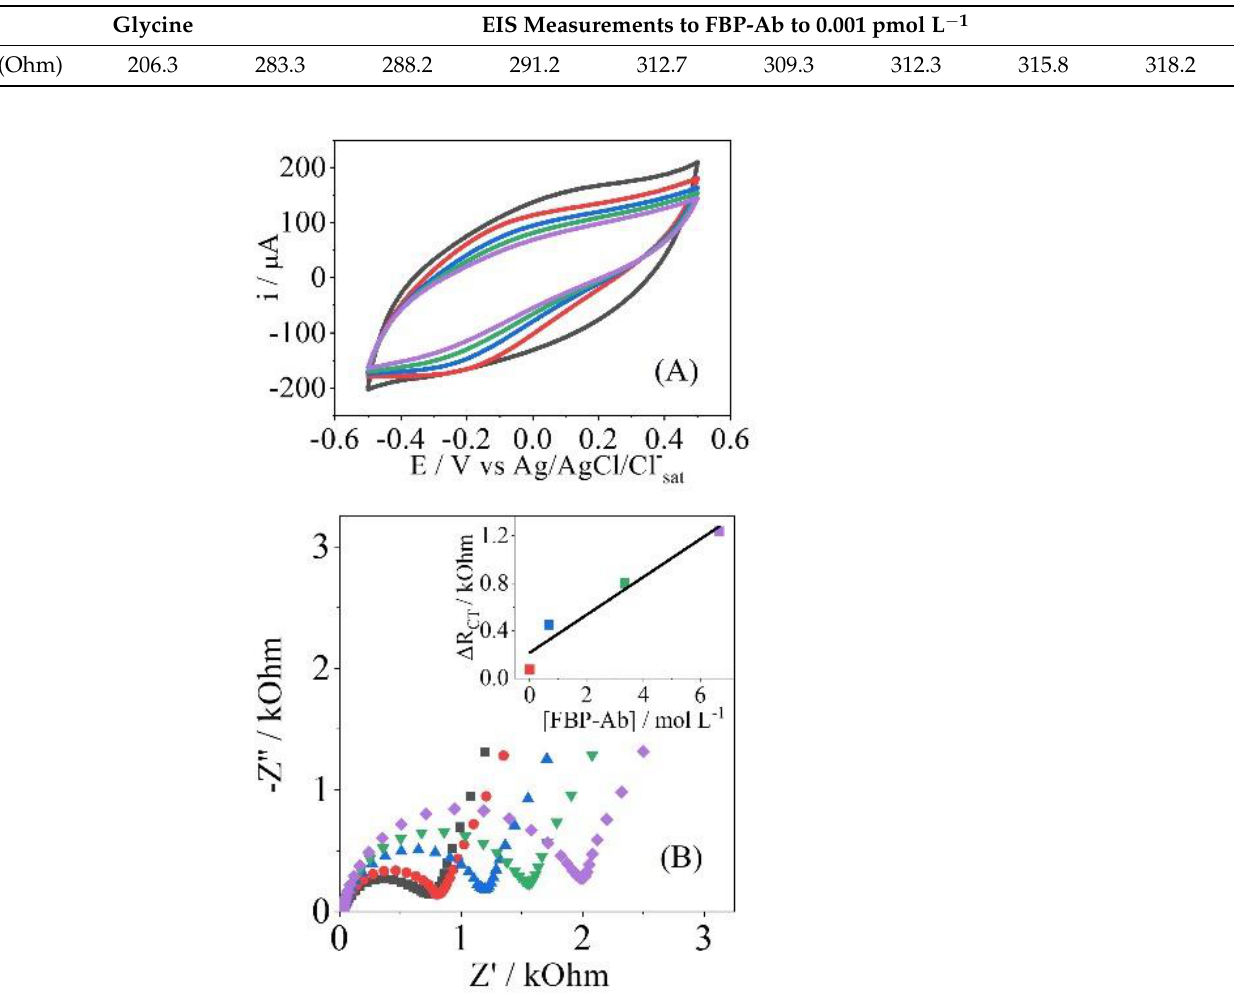
Figure A3. Adsorption test of different antibody concentrations (0.001, 0.67, 3.30, and 6.60 pmol L −1 ), using a modified electrode only with PPy. Cyclic voltammograms ( A ), Nyquist diagram ( B ).